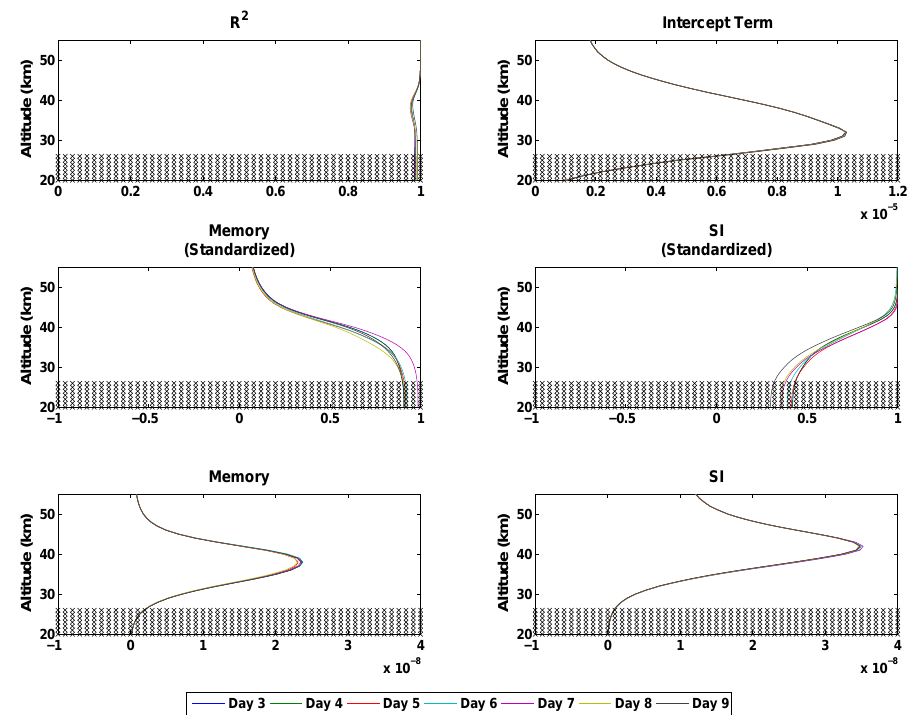
Fig. 4. Regression coefficients for the 2-predictor autoregressive model for simulation days 3 to 9 (different colours). Top row: adjusted coefficient of determination ¯ R 2 (left) and intercept term α 0 = ¯ y (right). Middle row: standardised memory term β (left) and standardised solar irradiance term γ (right). Lower row: non-normalised memory term β 0 (left) and non-normalised solar irradiance term γ 0 (right). Regions where the standard deviation (amongst the ensemble) in the observed variable y was smaller than 5% of the maximum standard deviation in the column are hatched